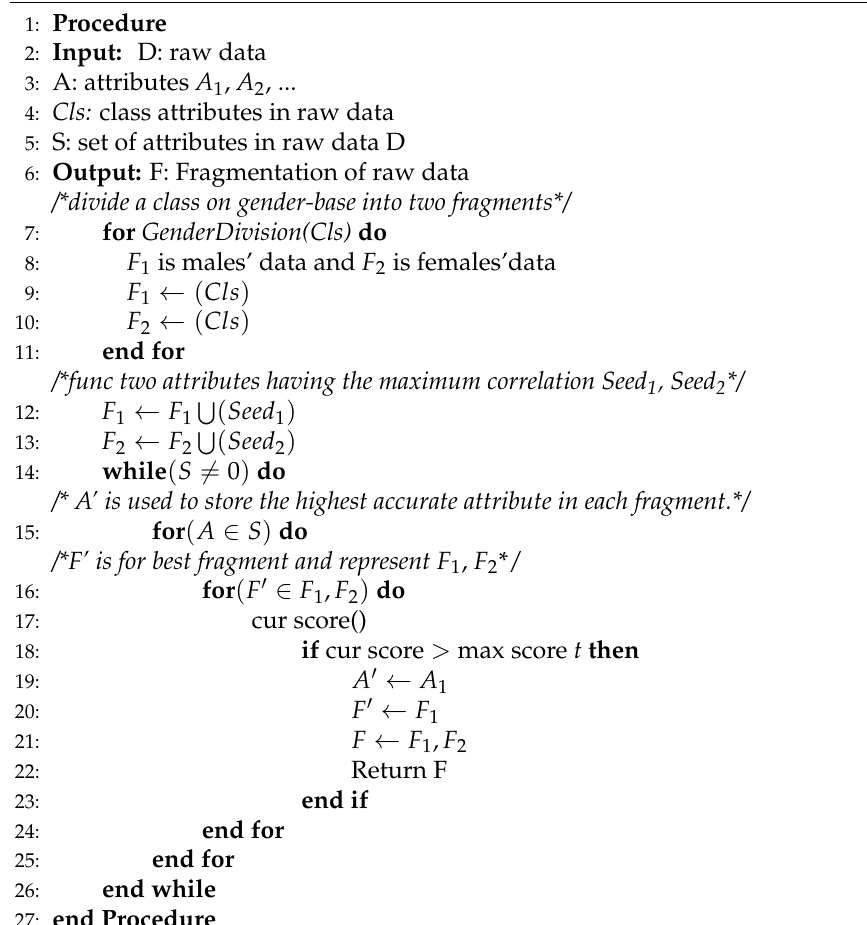
Algorithm 2 Fragmentation of the raw